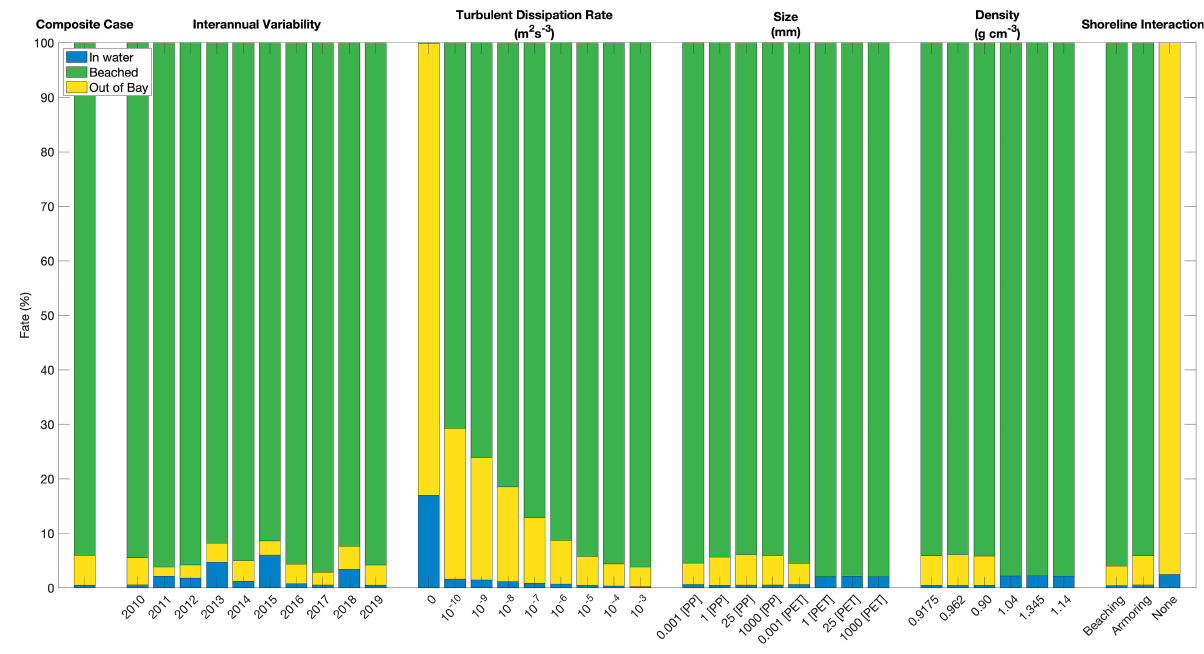
FIGURE 8 | Sensitivity test cases for the York River, indicating final particle fate percentages. All cases are identical to the composite case for positively buoyant particles (year 2010, turbulent dissipation rate 10 − 5 m 2 s − 3 , size 5 mm, density 0.90 g cm − 3 , and shoreline armoring) unless otherwise noted. Regarding Shoreline Interaction, Beaching and None are two options within unmodified Ichthyop that allow for particles to either beach everywhere along the entire shoreline or nowhere along the shoreline, respectively; Armoring is the modification test case that allows for particles to beach only along segments of coastline we specify within a variable in the ROMS grid file, the rest of the shoreline functioning as an armored